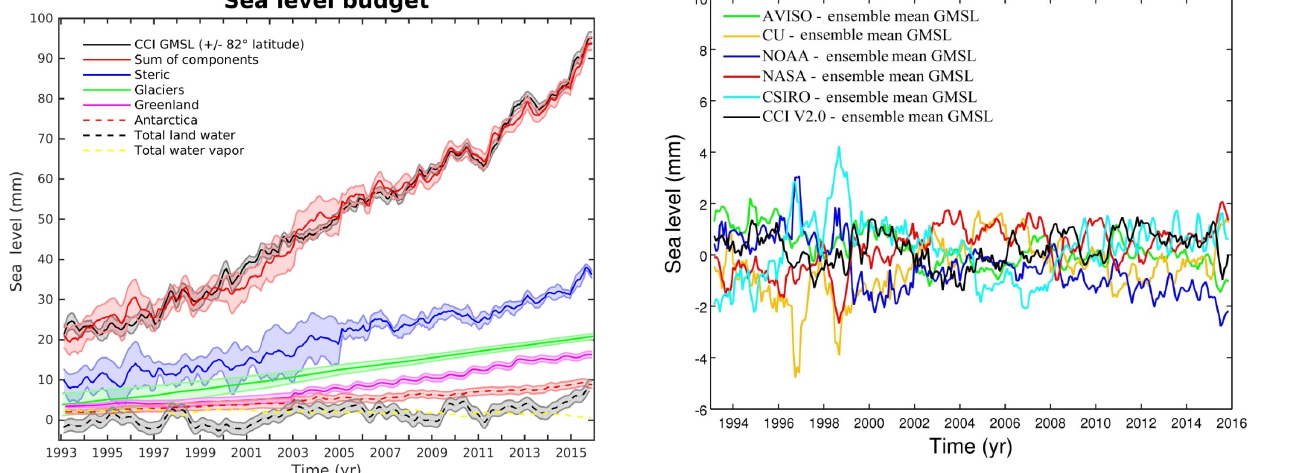
Figure 9. Sea level budget using the SL_cci v2.0 GMSL time series (adapted from Dieng et al., 2017). The 1.5mmyr − 1 correction sup- posed to represent the TOPEX-A drift has been applied (specifically in this figure) to the GMSL time series for 1993–1998 as discussed in Sect. 4.1 (see Dieng et al., 2017 for details).